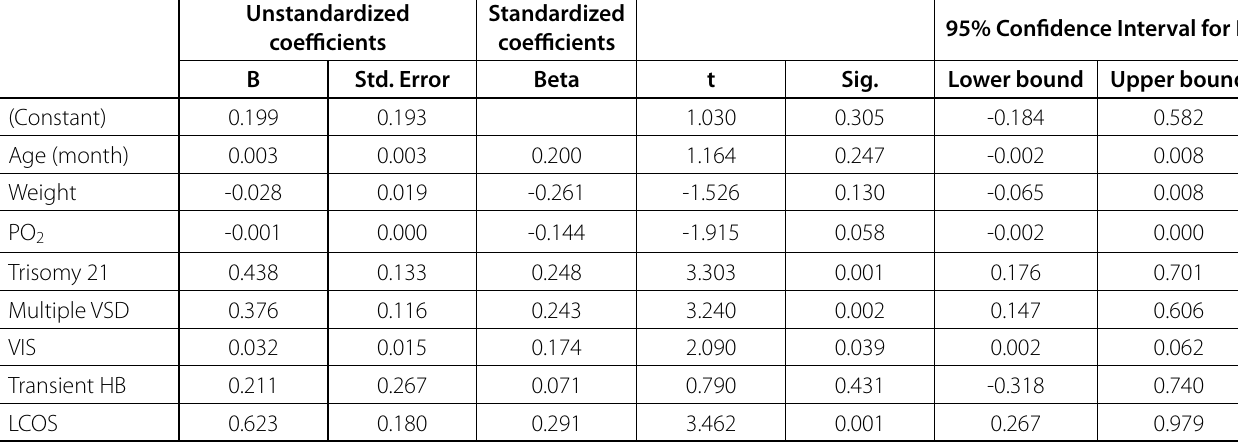
Table 4. Regression analysis.